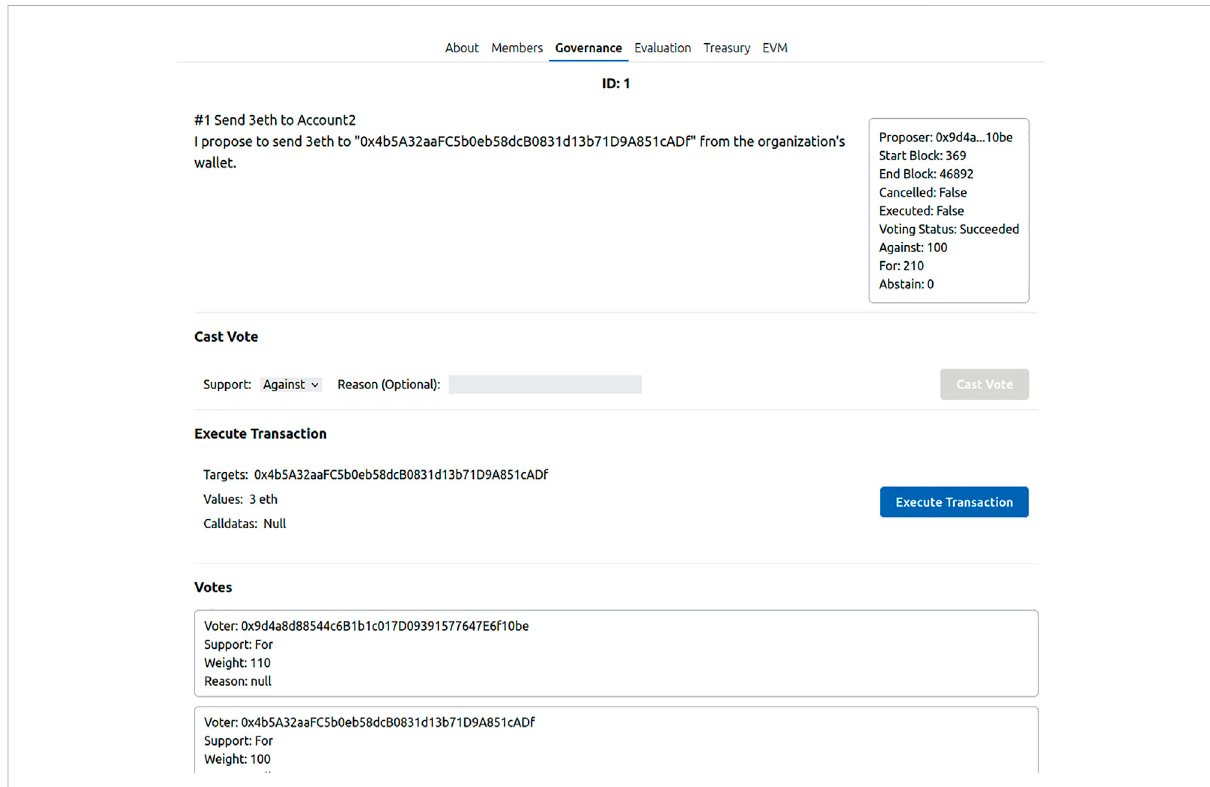
FIGURE 7 Theproposaldetailssectioninthefront-endsoftware.AsthestatushaschangedtoSucceeded,theExecuteTransactionbuttonisactivatedand the Cast Vote button is disabled. Anyone can con fi rm the voting